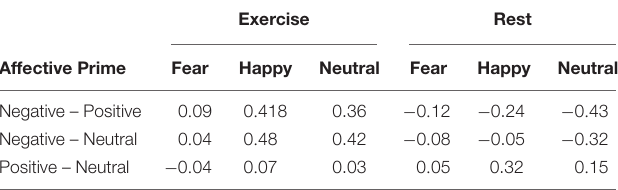
TABLE 3 | Estimation statistics on Area Under the